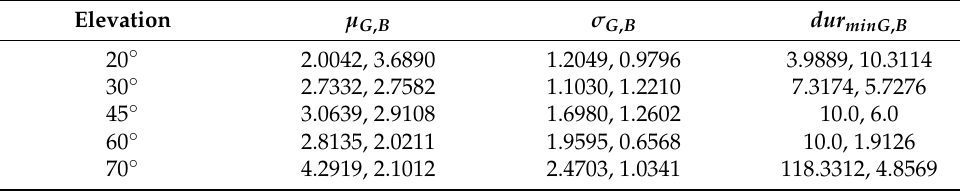
Table 1. Satellite link parameters for the dense urban area in France at 2.2 GHz [5]. Elevation µ G , B σ G ,